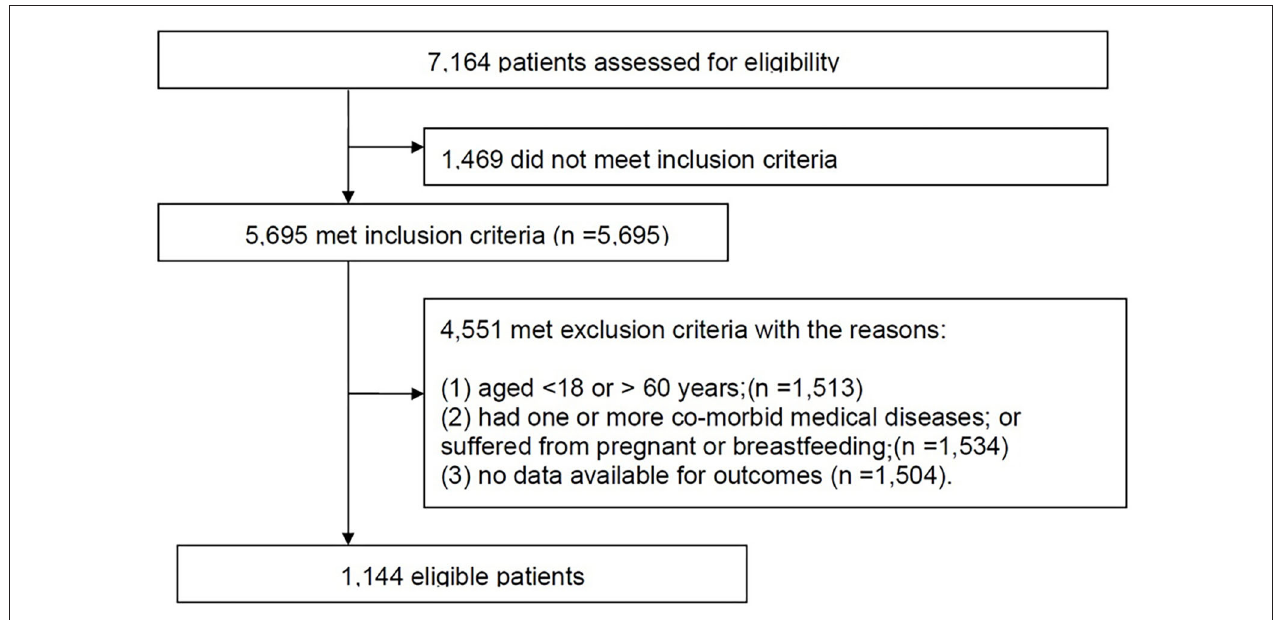
FIGURE 1 | The study inclusion and exclusion